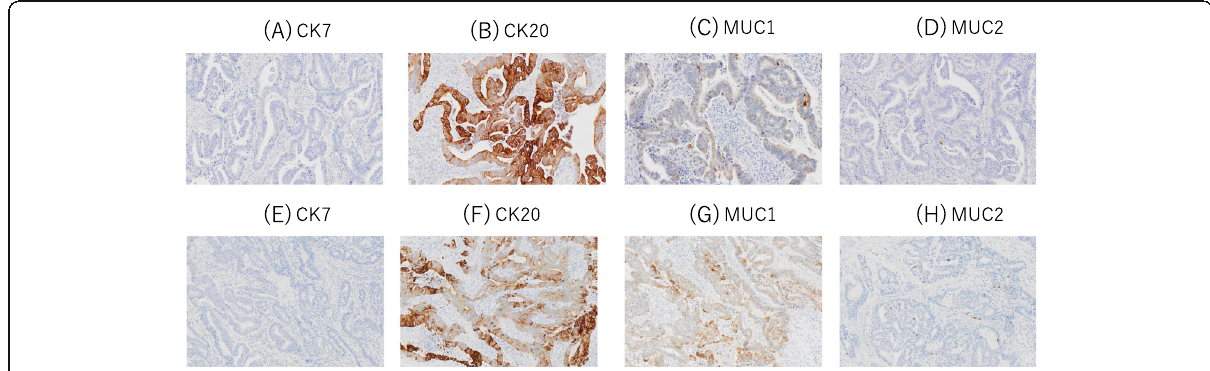
Fig. 8 Immunohistochemical analysis revealed identical profiles between the original ampullary carcinoma ( a – d ) and the remnant tumor ( e – h ). Both sites were as follows: CK7-negative ( a , e ), CK20-positive ( b , f ), MUC1-positive ( c , g ), and MUC2-negative ( d , h